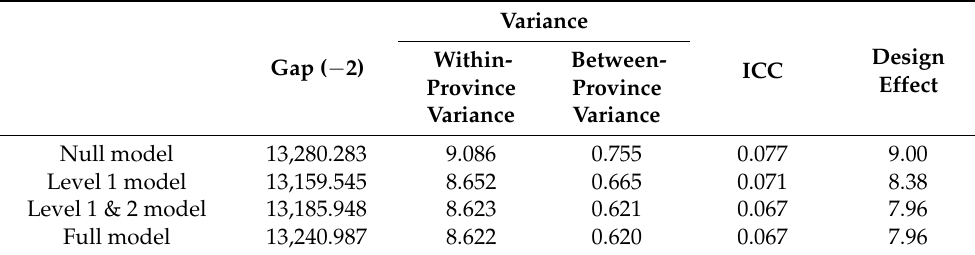
Table 2. The gap value, variance, and ICC value of models.